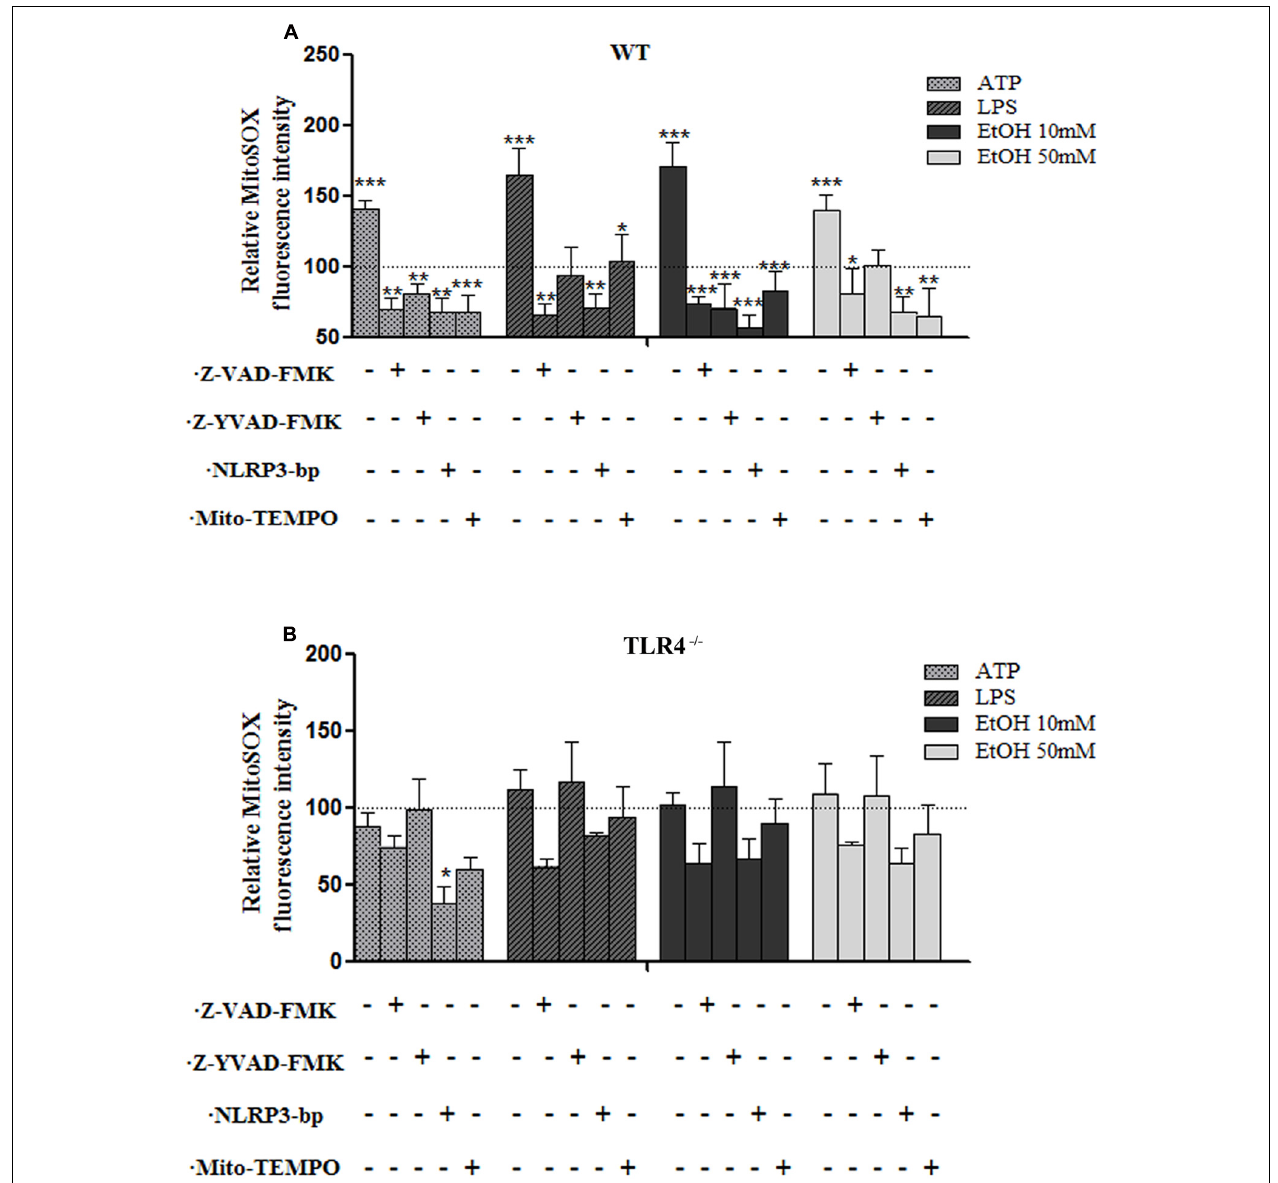
FIGURE 4 |The ethanol-induced mitochondria ROS production level measured by MitoSOX Red fluorescence intensity. (A) A flow cytometry analysis shows that the ATP or LPS or ethanol (10 and 50 mM) treatments increased mROS generation in theWT astrocytes. Incubation with Z-YVAD-FMK, Z-VAD-FMK, the NLRP3 blocking peptide or Mito-TEMPO before and during treatments notably reduces mROS generation activation in